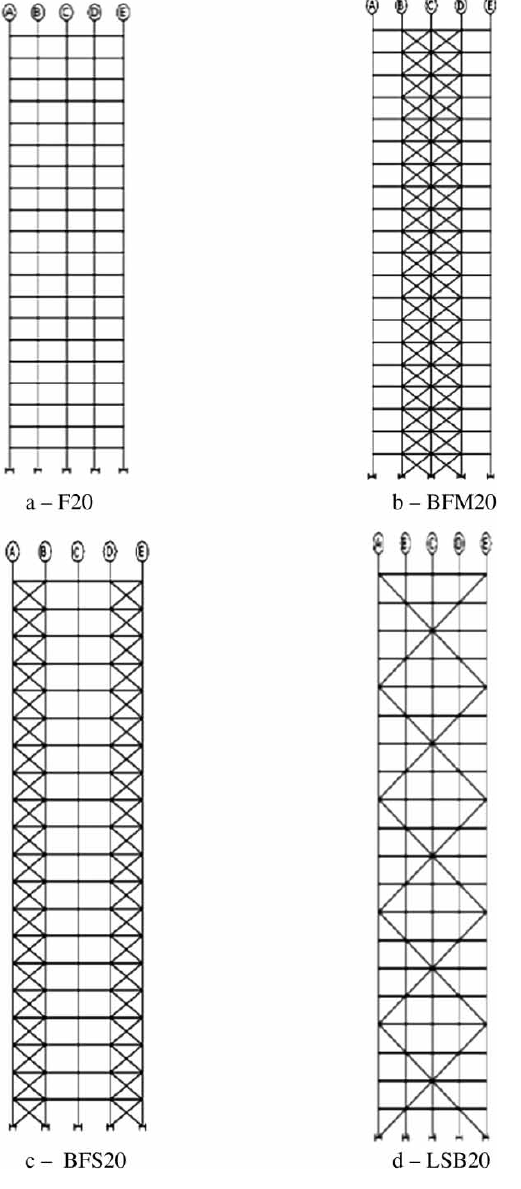
Fig. 13. Analytical